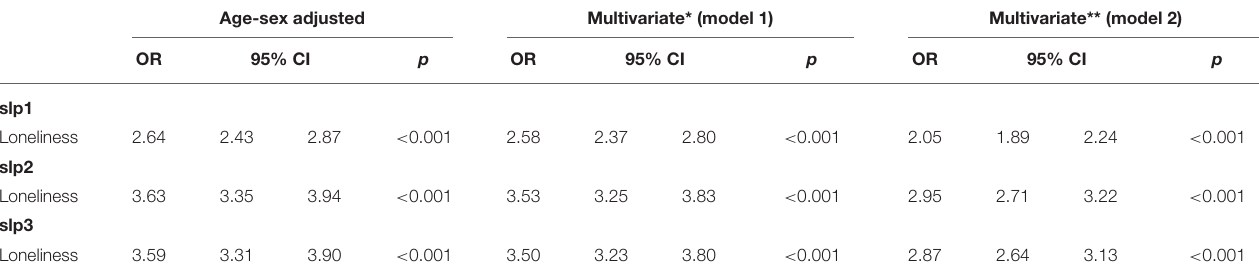
TABLE 2 | The association between loneliness and